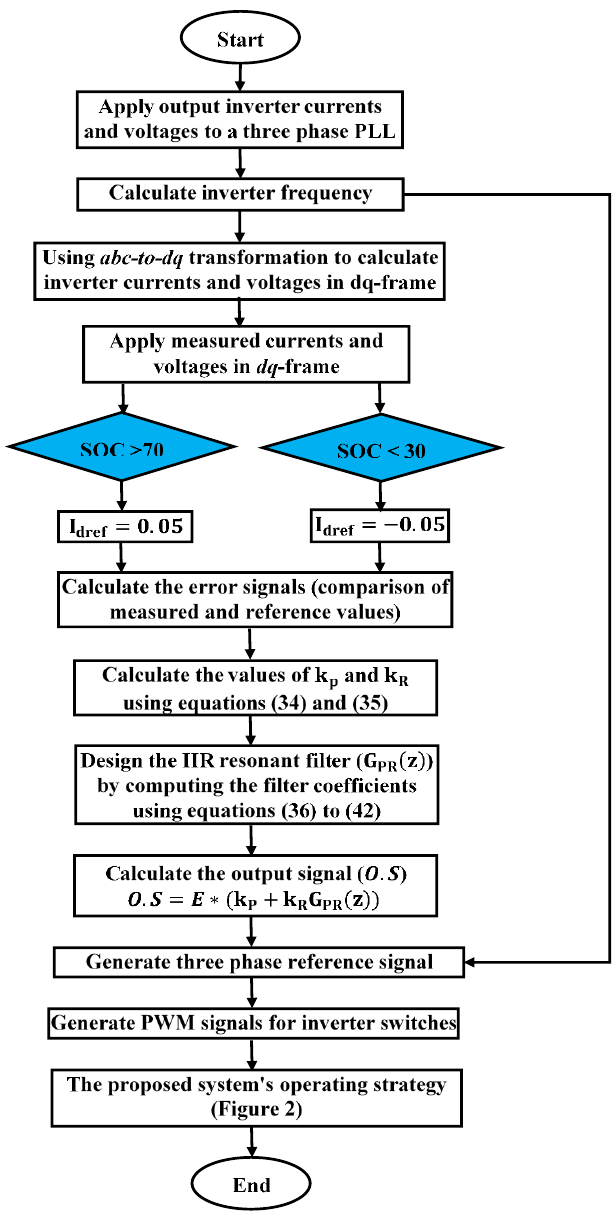
Figure 5. The flowchart of the proposed control strategy.